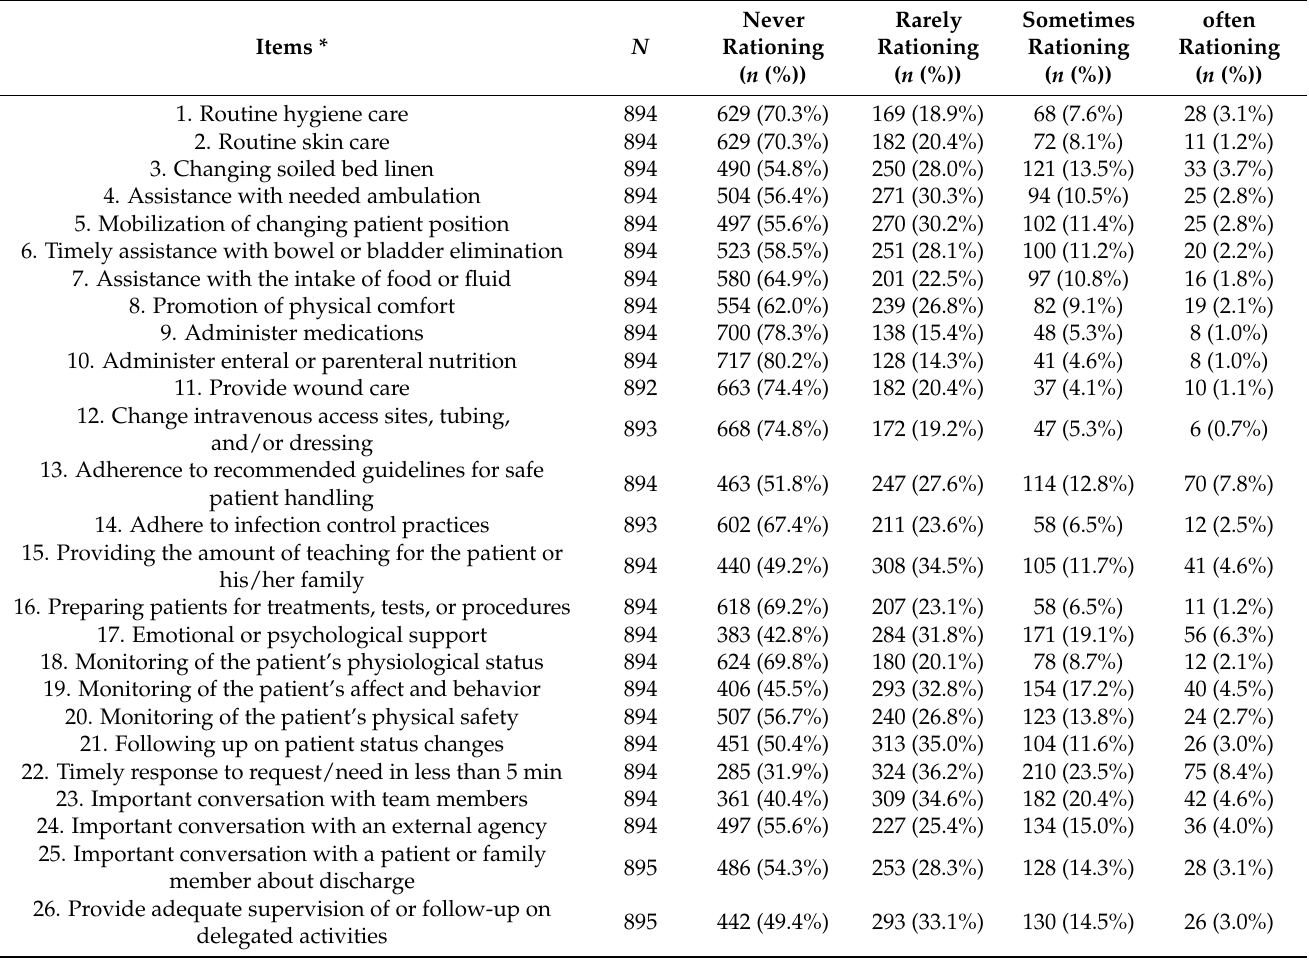
Table 1. Rationing of nursing care based on PIRNCA